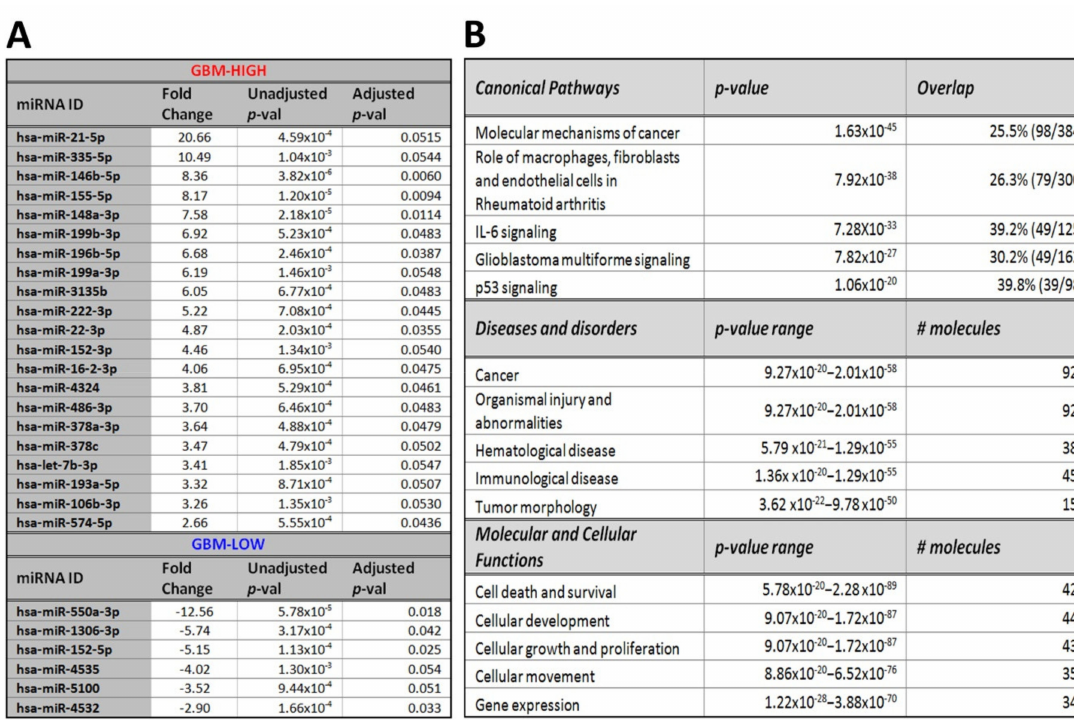
Figure 2. Significant miRNA species in GBM relative to astrocytoma GII-III CUSA-EVs. ( A ) Significant di ff erential-expression (DE) miRNAs in enriched CUSA-EVs captured during astrocytoma debulking surgeries. miRNAs with significantly high (GBM-high; (FC ≥ 2, B-H adj. p ≤ 0.05) and low (GBM-low; FC ≤ − 2, B-H adj. p ≤ 0.05) expression in GBM relative to GII-III CUSA-EVs are listed. ( B ) Functional pathway analysis of mRNAs targeted by 212 changing miRNAs ( p ≤ 0.05) in GBM CUSA-EVs. The top canonical pathways, diseases and disorders and molecular and cellular functions are listed with the number of overlapping molecules and significance associations (right-tailed Fisher exact test, p